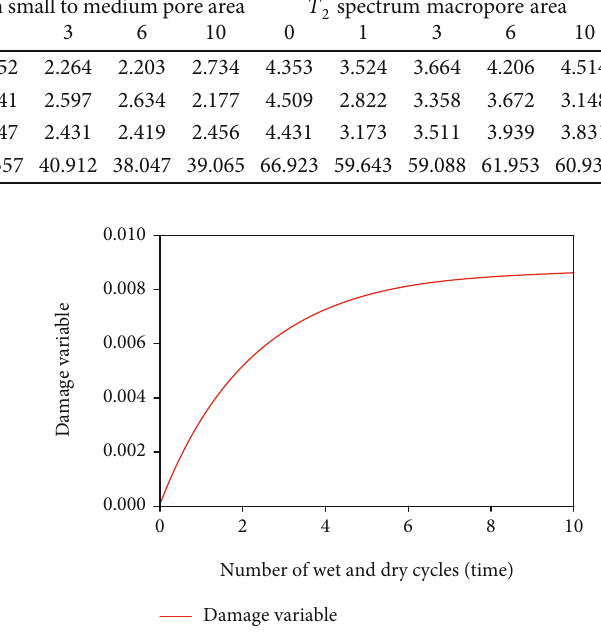
Figure 6: Variation curves of wet and dry cycles and damage 2